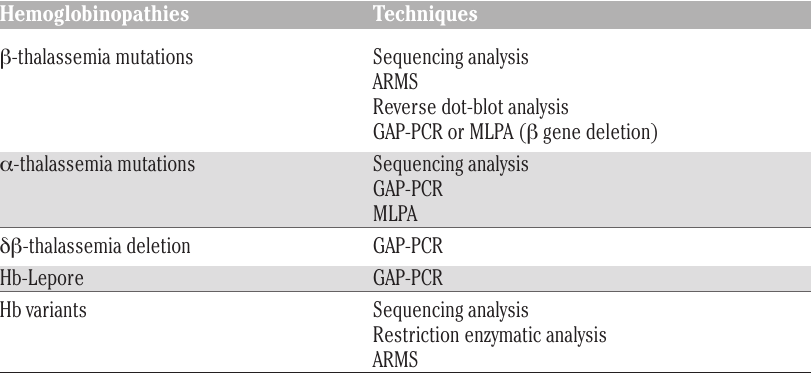
Table 1. Polymerase chain reaction-based techniques for the identification of known and unknown mutations of globin